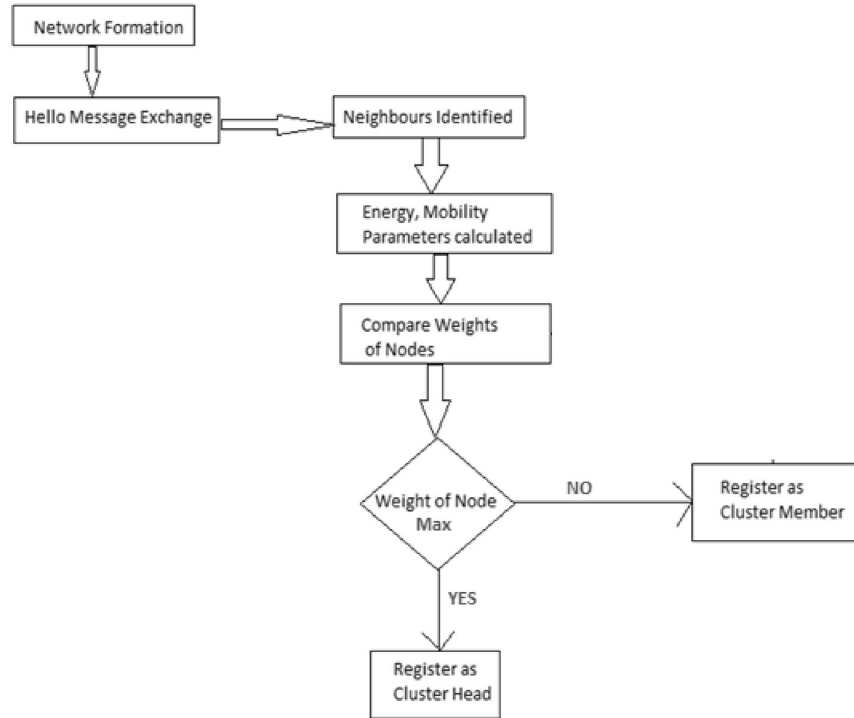
Fig. 2 Cluster formation flow